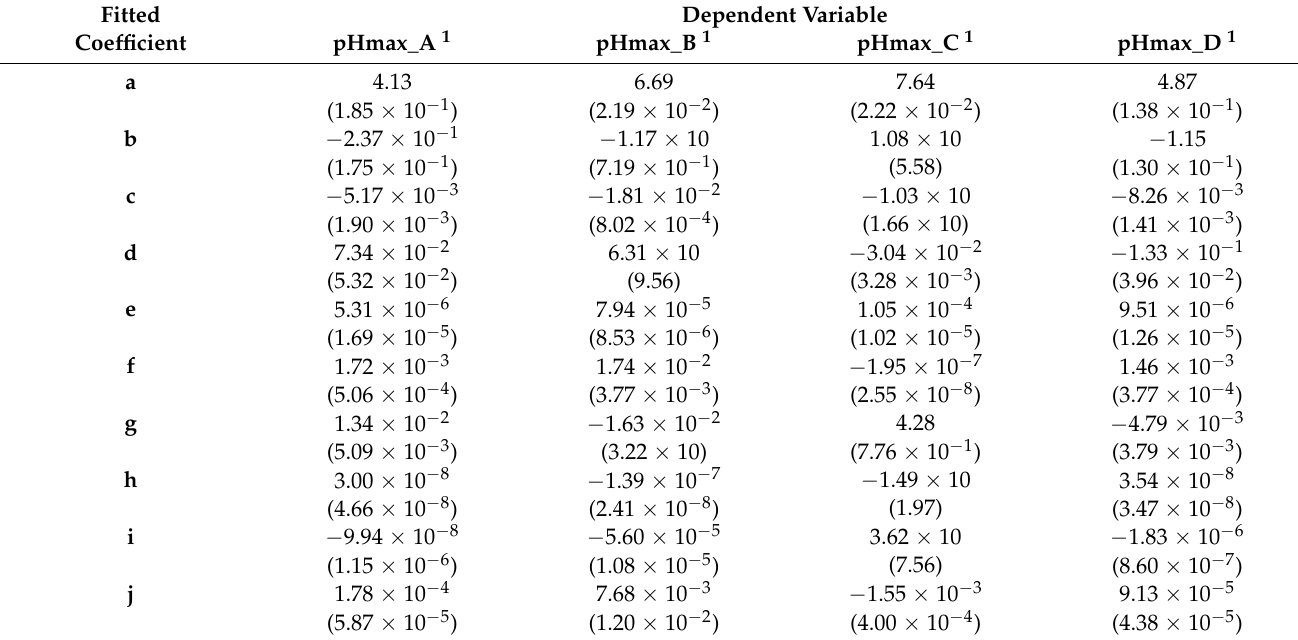
Table 3. Fitted coefficients and their standard errors (in parentheses) of the mathematical models, as shown in Equations (3)–(6).